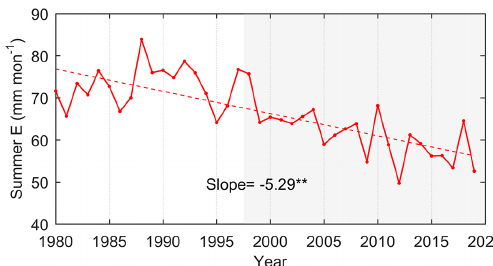
Figure 9. Time series of the IP summer evaporation from the ERA5 during 1980–2019 (unit of the slope: mm per month per decade). ∗∗ represents the 0.05 significance level of the